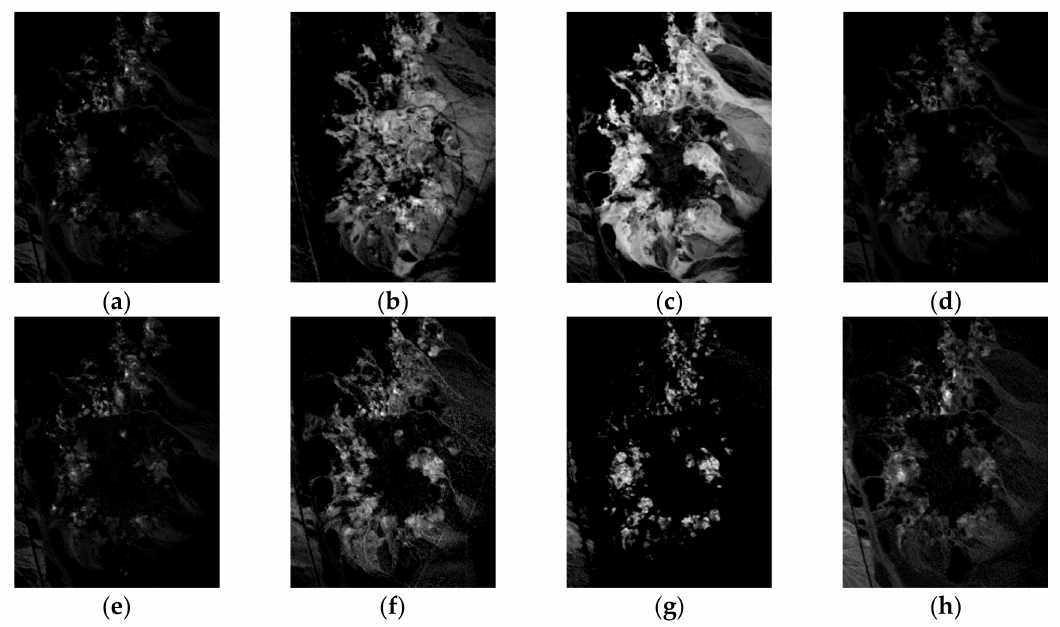
Figure 20. Jarosite + alunite 4: ( a ) VCA, ( b ) N-FINDR, ( c ) SGA, ( d ) C-NMF, ( e ) MVC-NMF, ( f ) ICE, ( g ) SPICE, ( h )